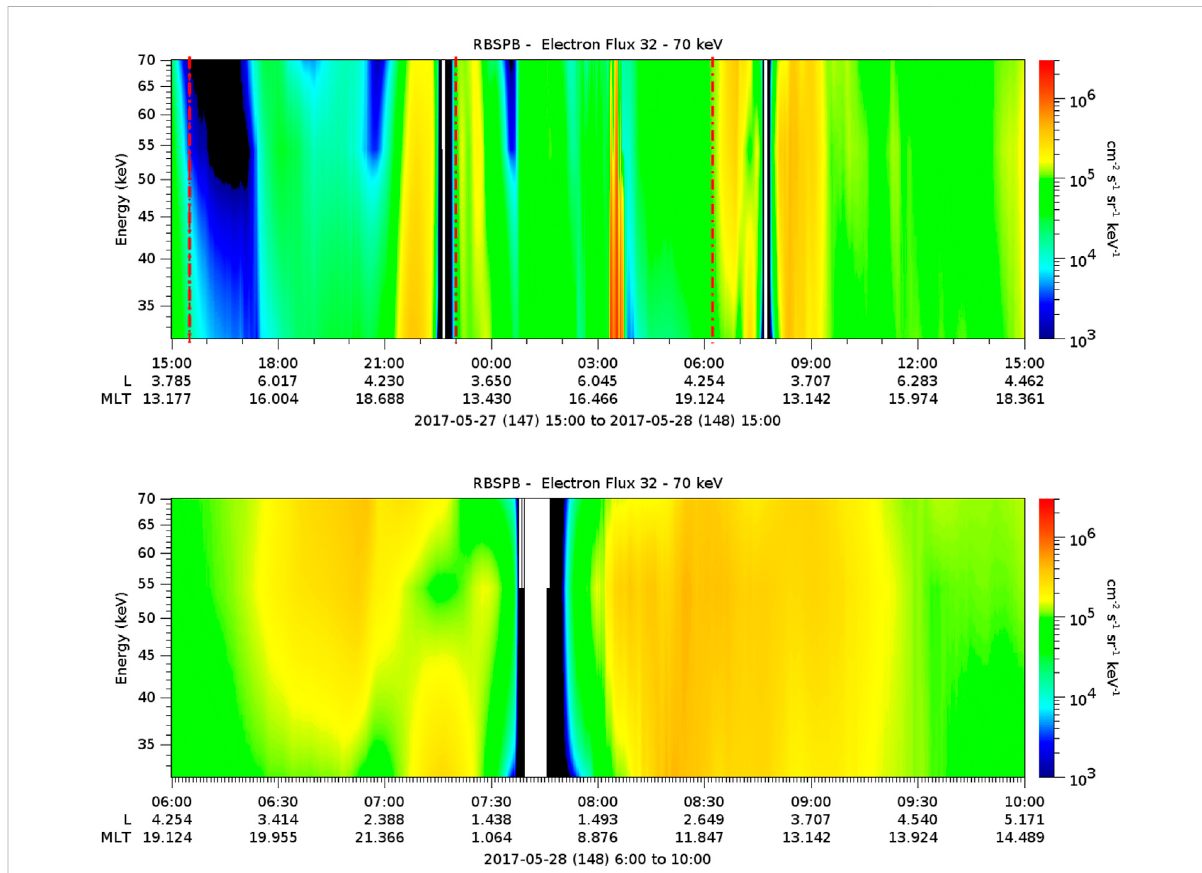
FIGURE 3 Low-energyelectron fl ux(32 – 70 keV)fromVanAllenProbeBduringthegeomagneticstormtime(top)andR-Ptime(bottom).Thestarttimeof the geomagnetic storm is considered here as approximately 2 hours before the sudden commencement phase and it ends approximately 8 hours after the beginning of the recovery phase. The low-energy electron fl ux is obtained from MagEIS instrument onboard Van Allen Probe (B) . This decontaminated data is available for this period only from Van Allen Probe (B) . The vertical dashed red lines refer to the onset time of the geomagnetic storm ’ s